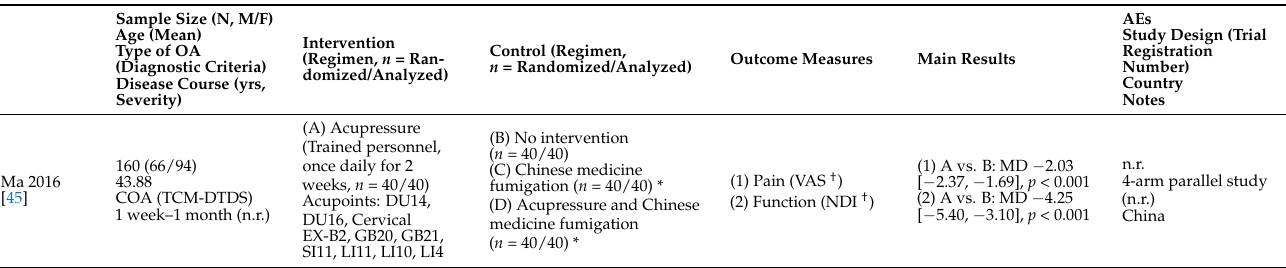
Table A1. Summary of